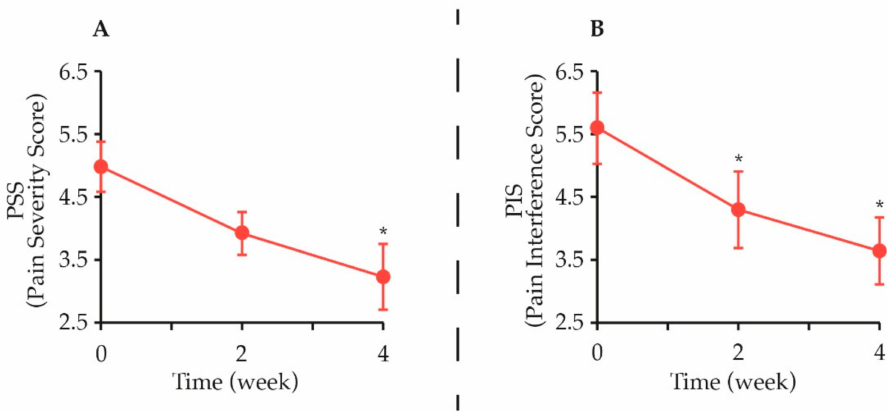
Figure 7. Dietary administration of PEA-q to privately owned dogs with chronic pain reduced the CBPI score. ( A ) During the four-week treatment, the mean severity of pain on PSS decreased significantly (*, p = 0.023). ( B ) The decrease of mean PIS was already statistically significant at the first control (week 2) and maintained a statistically significant decrease at the end of the study (week 4) (*, p = 0.009 for both comparisons). Drawn from data presented in